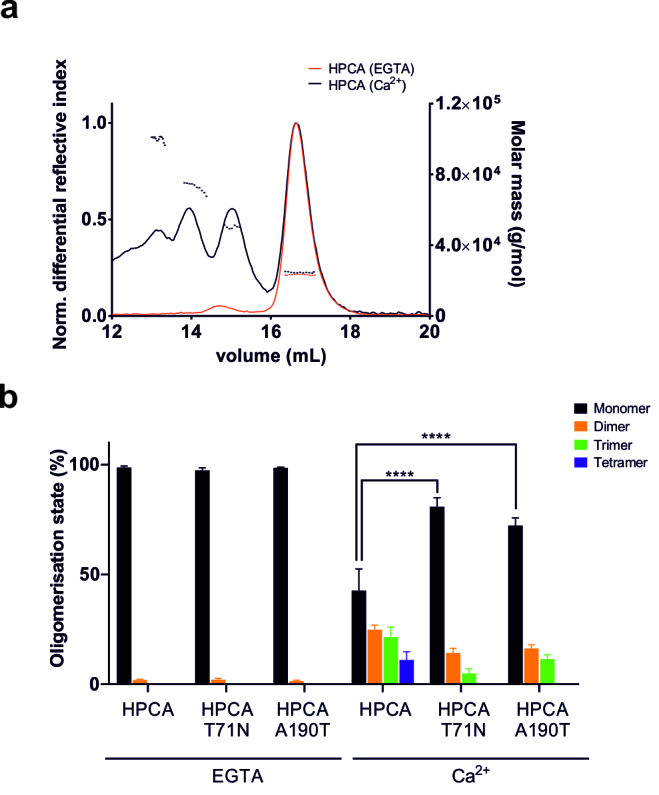
Defect of oligomerisation for hippocalcin mutants measured by SEC-MALS. (A) Representative SEC-MALS data obtained for hippocalcin wild-type showing a monodisperse sample in the presence of 5 mM EGTA (red) (consistent with a monomer) compared to a polydisperse sample in the presence of 1 mM CaCl2 (black) (consistent with a mixture of monomer, dimer, trimer and tetramer). The average molar mass is indicated in dotted line and the differential refractive index in plain line. (B) Analysis of the MALS data for hippocalcin wild-type and mutants in the presence or absence of Ca2+. Molar mass of each peak is shown in Supplementary Material, Table S2.